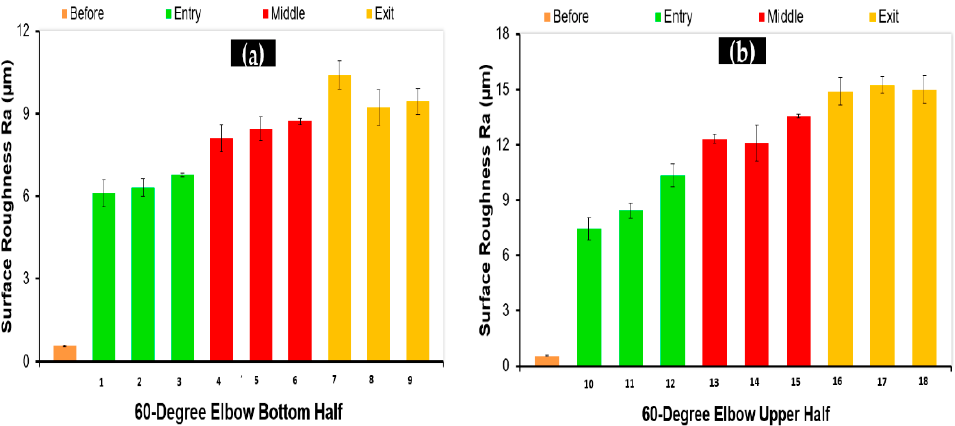
Figure 9. Arithmetic surface roughness values (Ra) before and after tests in the 60° elbows: ( a ) bottom; ( b ) top.